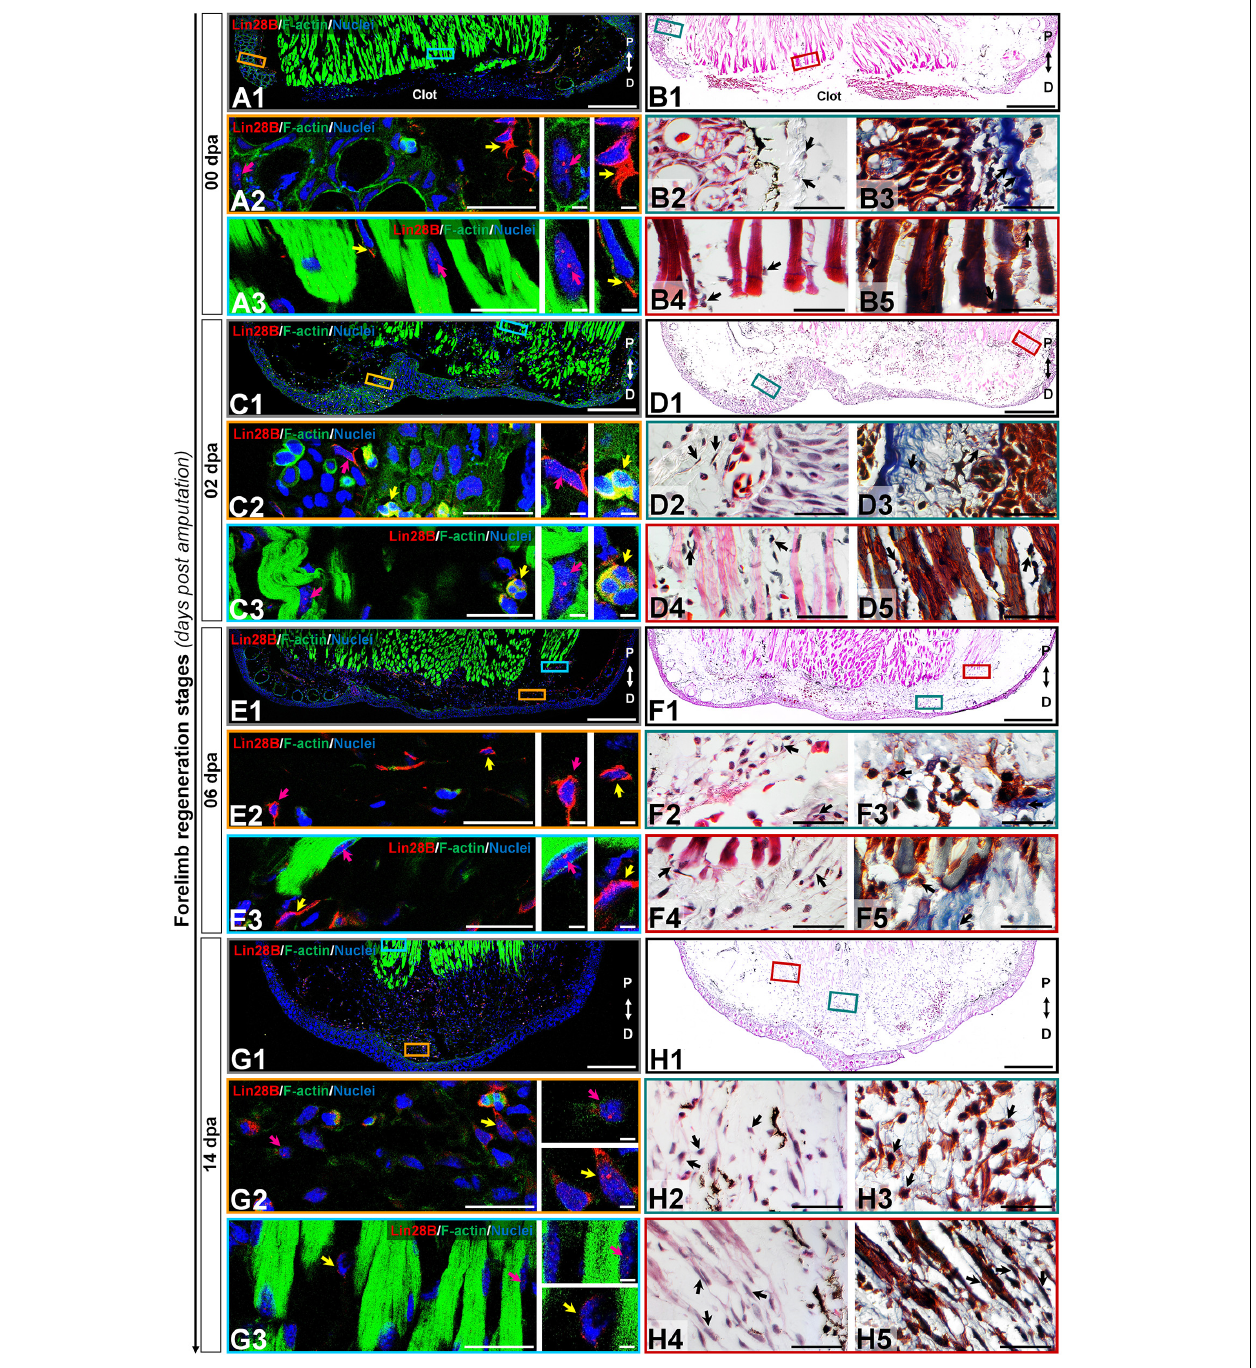
FIGURE 3 | Subcellular immunolocalization of amxLin28B during forelimb regeneration. (A–H) Histological sections of representative stages during the limb regeneration oriented in the Proximal-Distal axis. (A,B) Uninjured limb (00 dpa). (C,D) Wound healing stage (02 dpa). (E,F) Apical epidermal cap stage (06 dpa). (G,H) Early blastema stage (14 dpa). (A1,C1,E1,G1) Intracellular localization dynamics of amxLin28B marked in red, by contrast with DAPI (blue) and Phalloidin (green) that delimit nuclei and cell shapes, respectively. Scale bars: 500 µ m. (A2-3,C2-3,E2-3,G2-3) Magnifications with different color contours to remark some areas of interest for amxLin28B in red, DAPI in blue, and Phalloidin in green; arrows in yellow and magenta have in turn their own zoom in. Scale bars: 50 and 5 µ m, respectively. (B1,D1,F1,H1) The architectural organization of tissues is shown with Hematoxylin and Eosin staining. Scale bars: 500 µ m. (B2/4,D2/4,F2/4,H2/4) Magnifications with distinct color contours to indicate some areas of interest in Hematoxylin and Eosin staining. Scale bars: 50 µ m. (B3/5,D3/5,F3/5,H3/5) Histological changes detected on extracellular matrix for similar zones indicated in H&E ampliations, which are displayed with a differential staining to connective tissue. Scale bars: 50 µ m. The different arrows indicate diverse tissue components, as described in results.